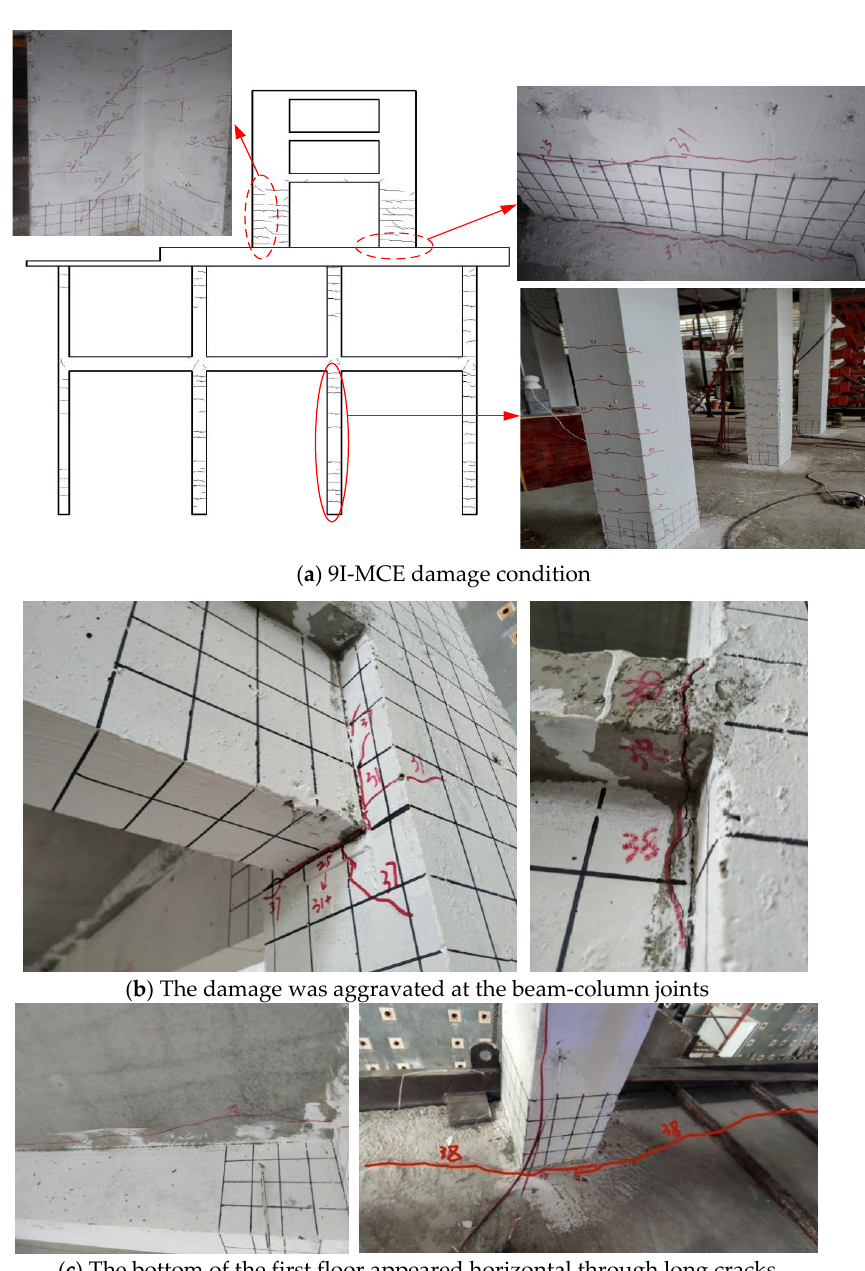
Figure 17. 9I-MCE damage